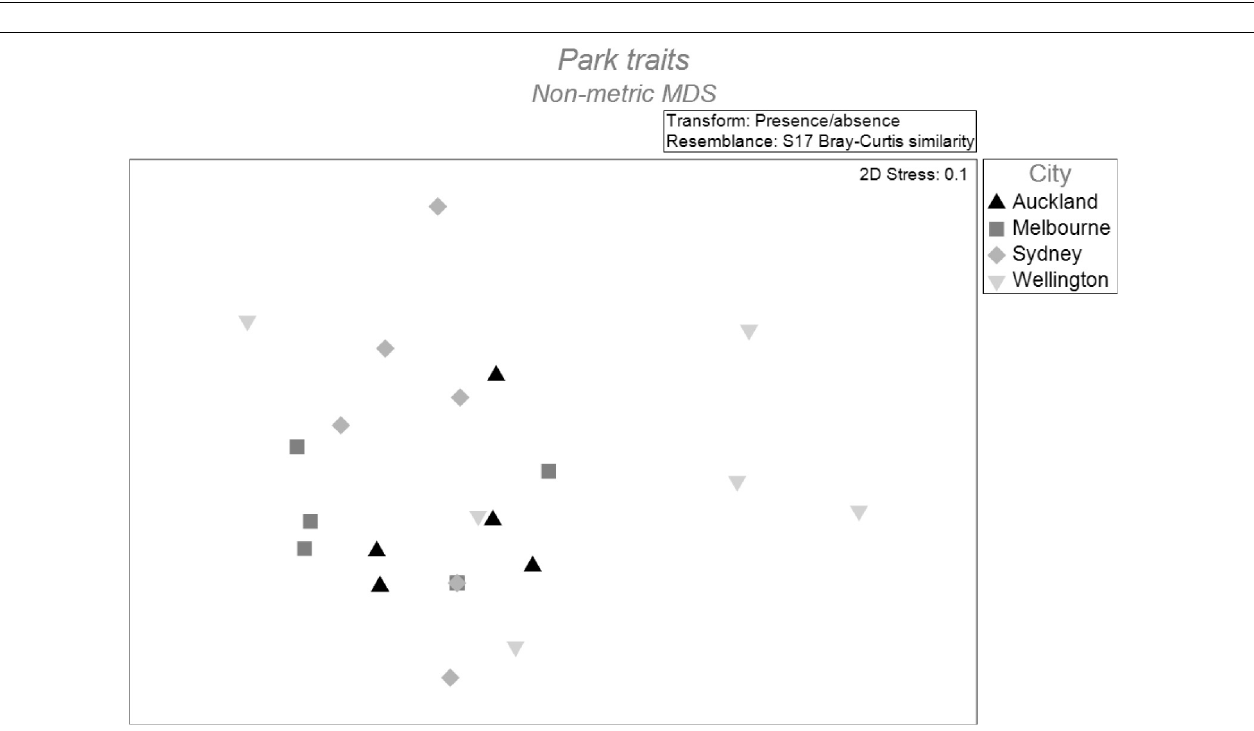
FIGURE 3 | Non-metric multi-dimensional scaling (nMDS) ordinations based on Bray–Curtis similarities of parks based on differences in park traits.